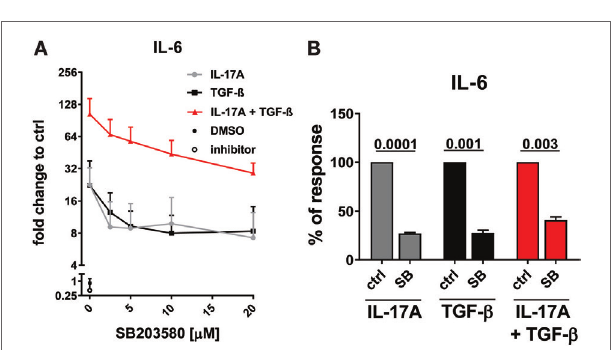
FigUre 5 | p38 MAPK signaling pathway is common to IL-17A- and TGF- β -induced IL-6 production. Healthy donors fibroblasts were treated with the indicated concentrations of SB203580 (a) or 20 µM SB203580 (B) for 1 h prior to the addition of IL-17A (25 ng/ml) and/or TGF- β (2.5 ng/ml) in triplicates. After 48 h, culture SNs were collected and IL-6 levels were assessed by ELISA. (a) Results are shown as fold change to untreated cells, mean + SEM is indicated, N = 3. Please note the log 2 scale. (B) Results are shown as the percentage of IL-6 production induced by IL-17A and/or TGF- β in the absence of inhibitor (levels of IL-6 were: 14.7 ± 7.4 pg/ml for IL-17A, 11.4 ± 6.1 pg/ml for TGF- β , and 48.9 ± 13.7 pg/ml for IL- 17A + TGF- β ). Bars represent the mean + SEM of three experiments. Significant differences versus control were assessed by paired t -test.